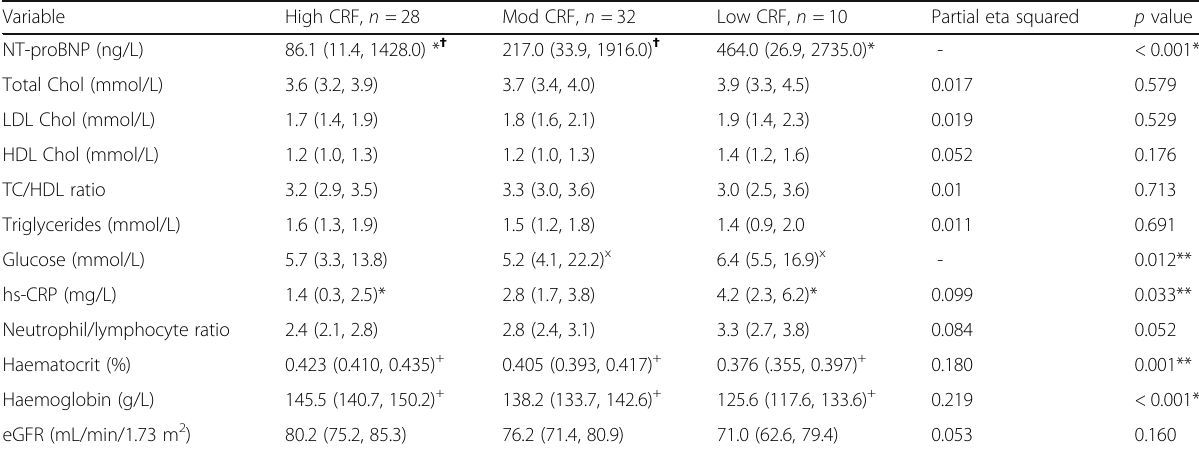
Table 5 Blood Biomarkers Expressed as Mean (95% Confidence Intervals) Variable High CRF, n =